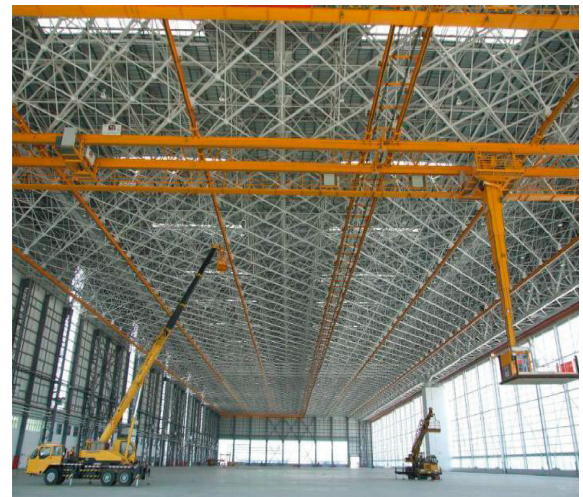
Figure 1: Grid structure with WHSJs with suspended